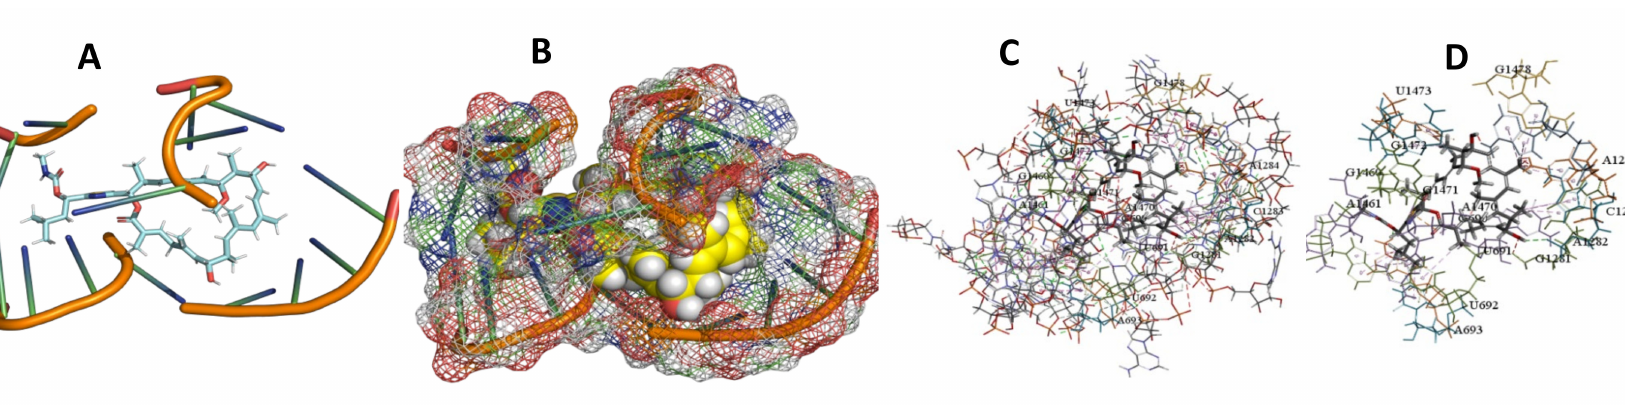
Figure 13. T. Brucei + Archazolid. ( A ): Best binding pose and nucleotides involved. ( B ): Schematic binding pocket. ( C ): shows the Nucleotides component that re involved in binding. ( D ): Shows the main bonds involved between the compound and the nucleotide